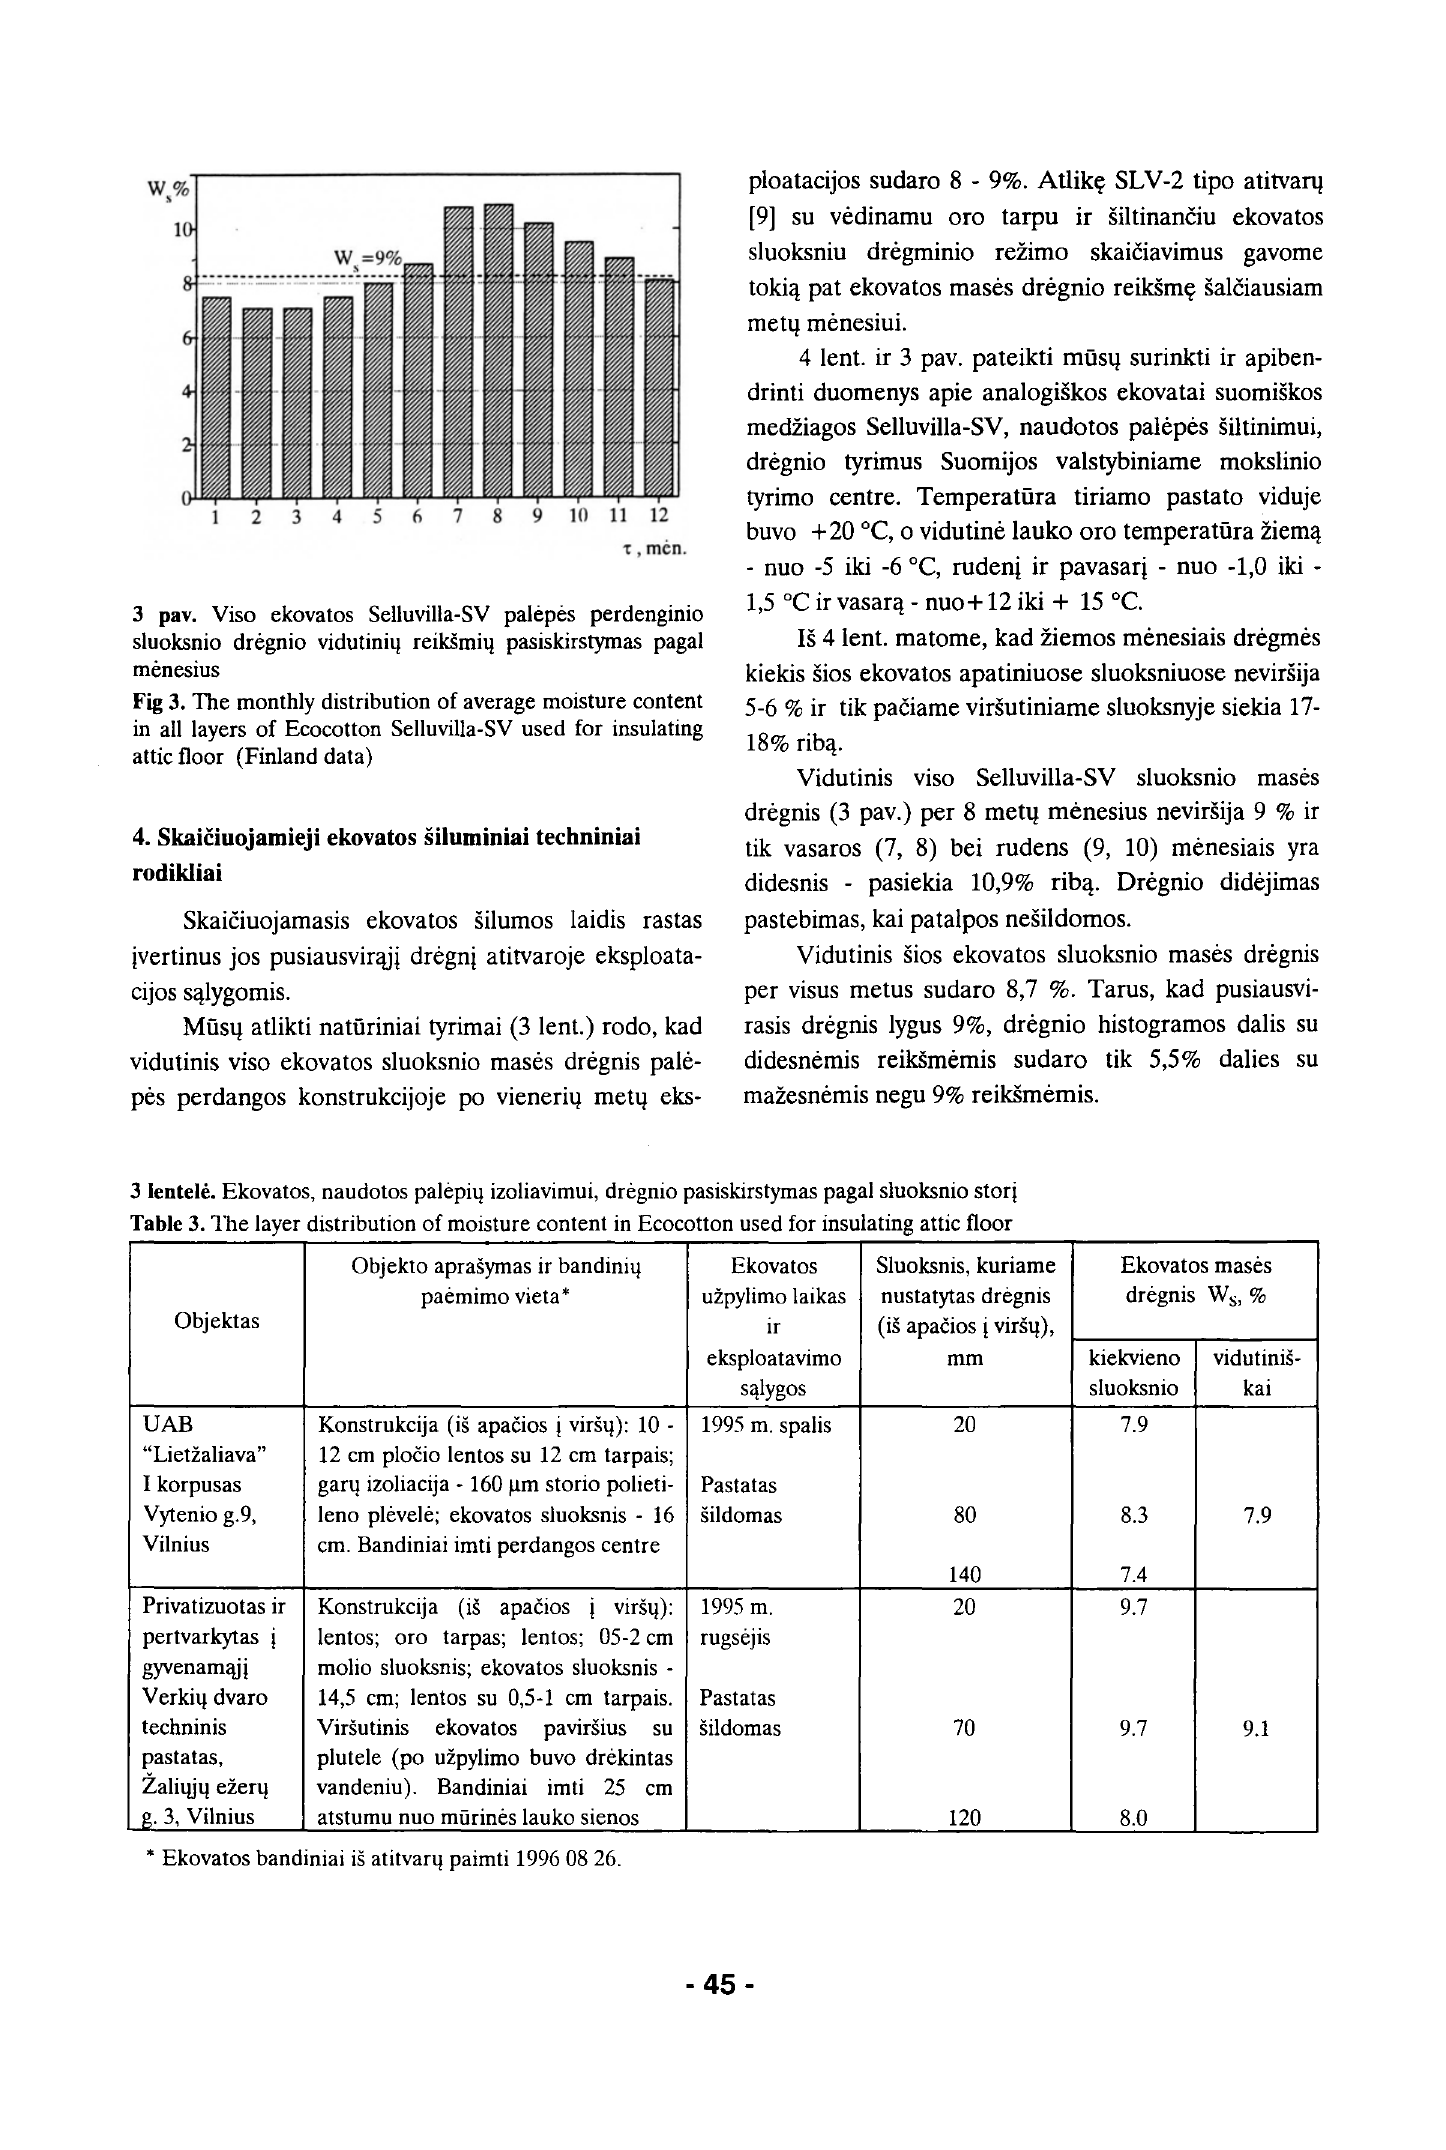
sluoksnio dregnio vidutiniq reikSmiq pasiskirstymas pagal menesius Fig 3. The monthly distribution of average moisture content in all layers of Ecocotton Selluvilla-SV used for insulating attic floor (Finland data)